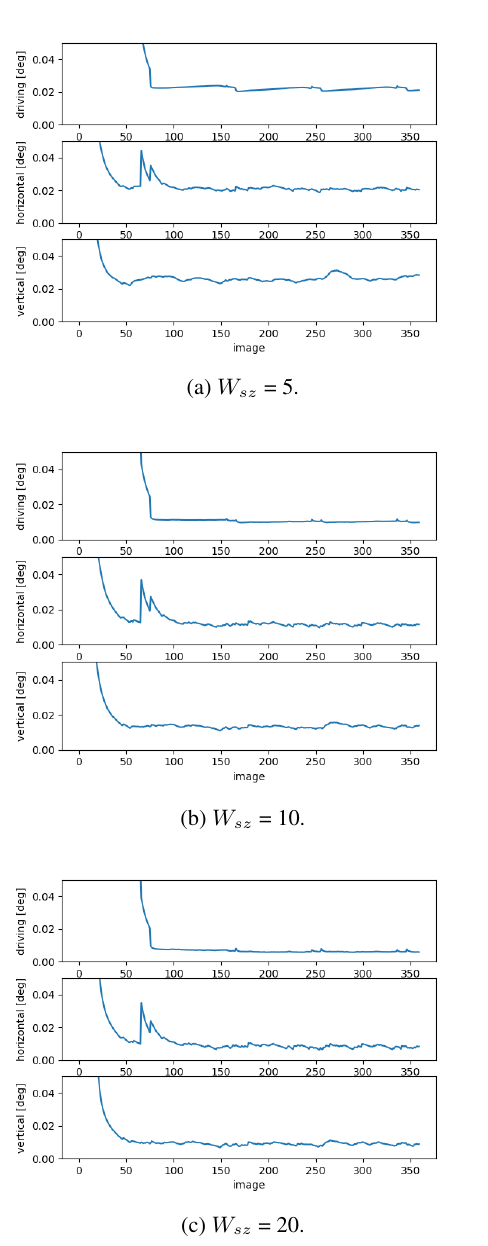
Figure 10. Precision of the angle around the vertical and the horizontal image axes and the driving direction at W sz 10, 20 and